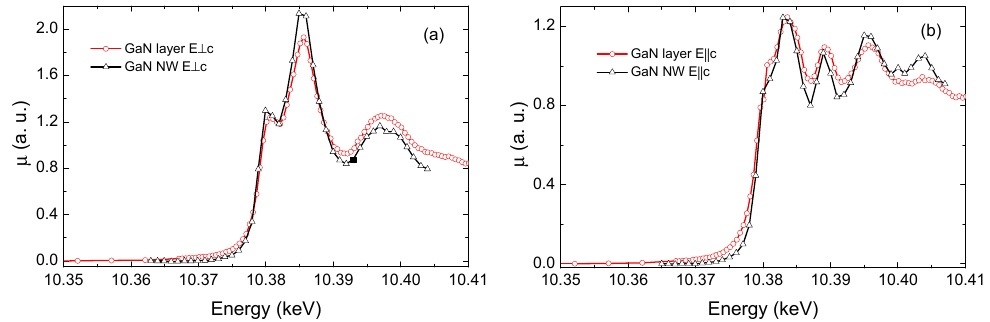
Figure 5. Comparison between X-ray absorption near edge structure (XANES) spectra of a high quality reference GaN layer (red cercles) and those of the NW (black triangles) for different X-ray beam incident angles: polarization ( a ) perpendicular and ( b ) parallel to the wurtzite c -axis.